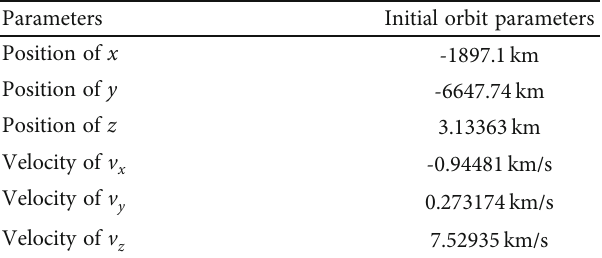
Table 2: Initial orbit parameters.